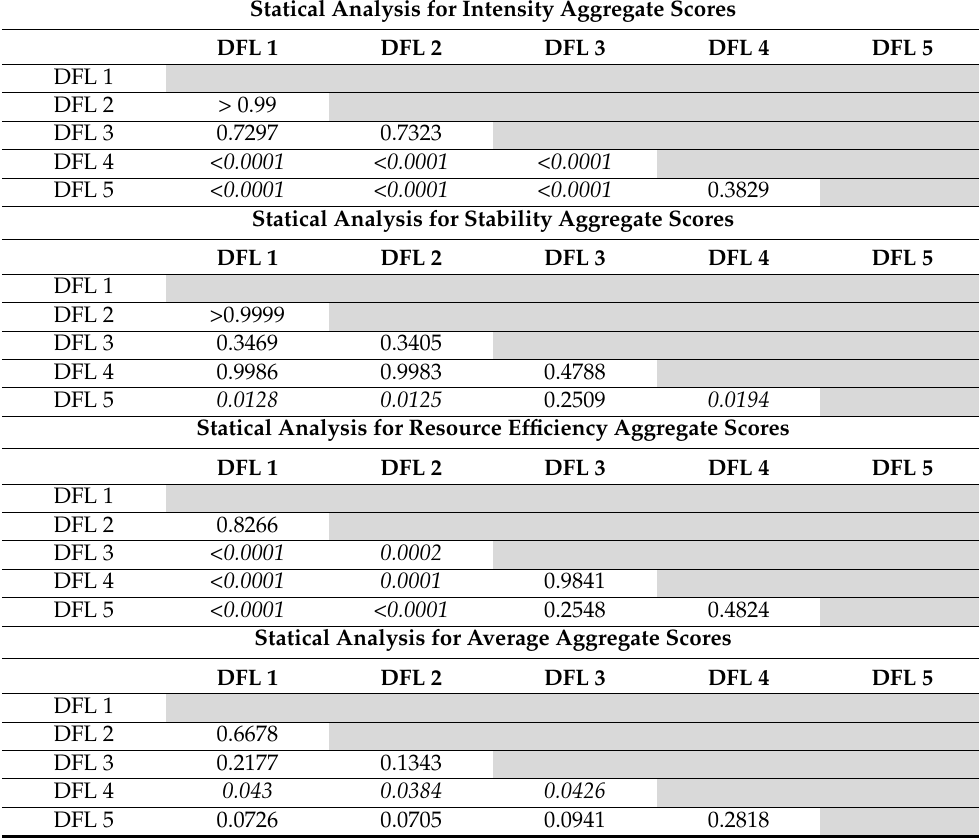
Table A5. Summary of statistical analysis for aggregate metrics averaged across all tested scenarios. p < 0.05 indicated statistical significance. Values are italicized when this threshold was reached for the particular comparison